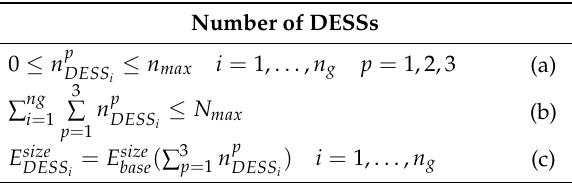
Table 1. Constraints on the Installation of distributed energy storage systems